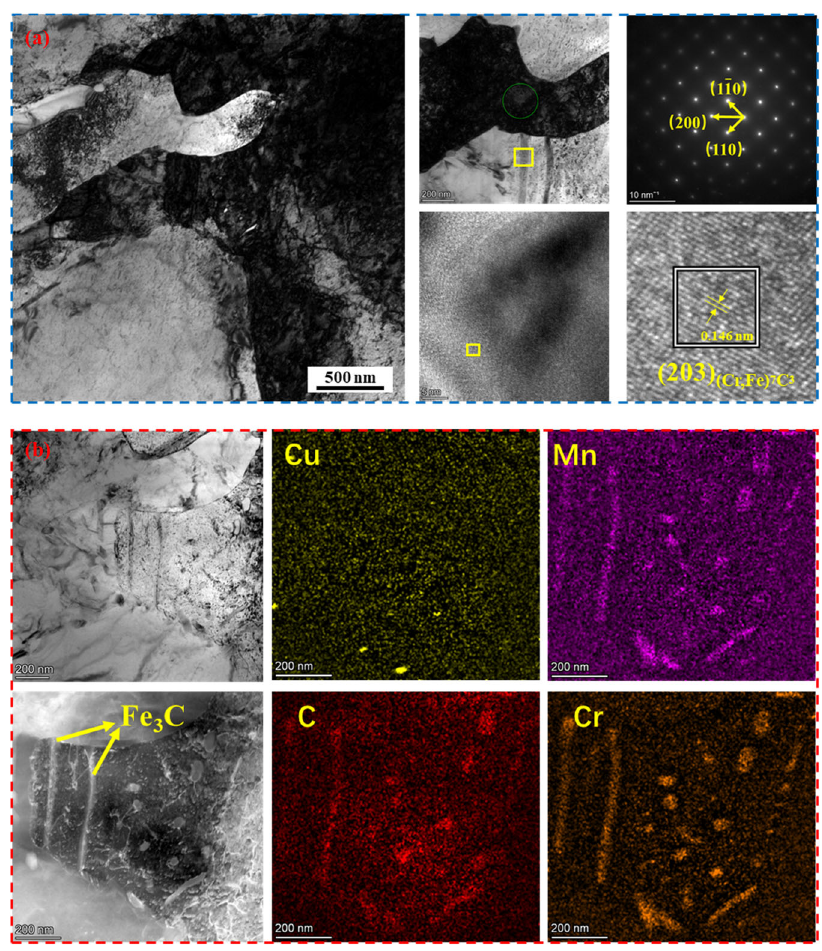
Fig. 3 Segregation of corrosion-resistant elements in grain and cementite. a SAED analysis of adjacent grains in the pearlite. b EDS analysis of cementite and grain internal with corrosion-resistant